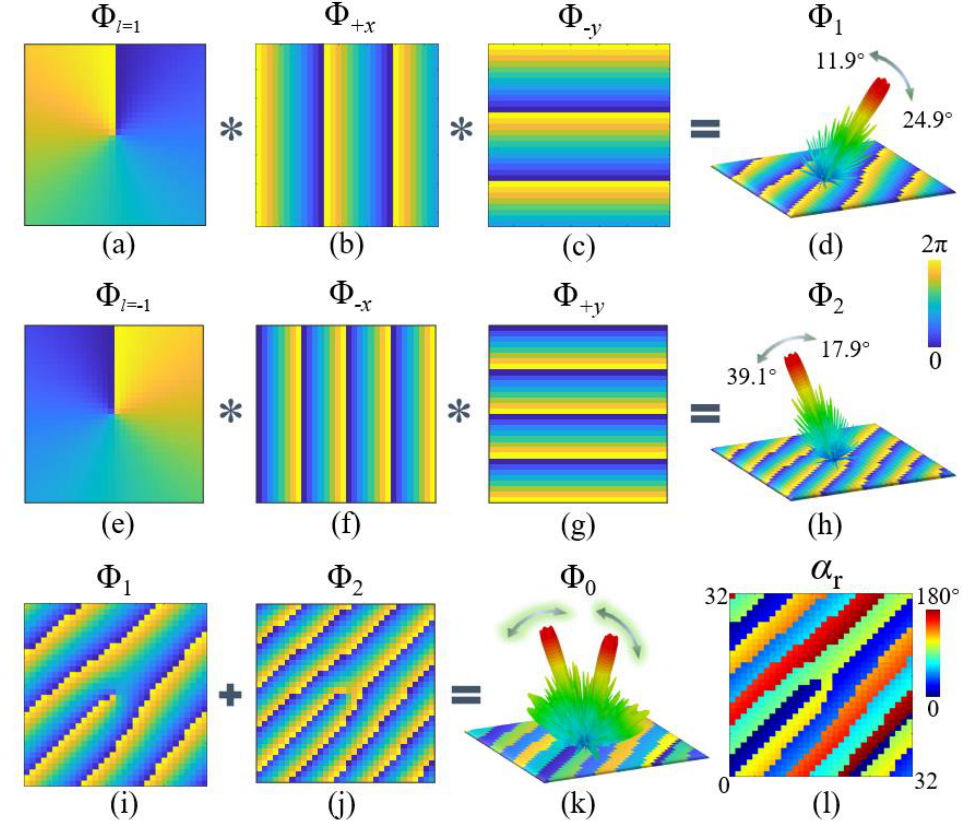
Figure 4. Phase distribution and rotating angles. ( a ) Phase profile Φ l = 1 of OAM vortex generation with topological charge l = 1. Phase gradient sequences ( b ) Φ + x and ( c ) Φ − y orientating to + x - and − y -directions with period Γ = 96 mm. ( c ) Phase profile Φ 1 by the convolution operation. ( d ) Phase profile Φ 1 by the convolution operation. ( e ) Phase profile Φ l = − 1 of OAM vortex generation with topological charge l = − 1. Phase gradient sequences ( f ) Φ − x and ( g ) Φ + y orientating to − x and + y directions with period Γ = 64 mm. ( h ) Phase profile Φ 2 by the convolution operation. ( i ) Φ 1 . ( j ) Φ 2 . ( k ) Phase profile Φ 0 by complex addition of Φ 1 and Φ 2 . ( l ) Rotating angles α r of the metallic